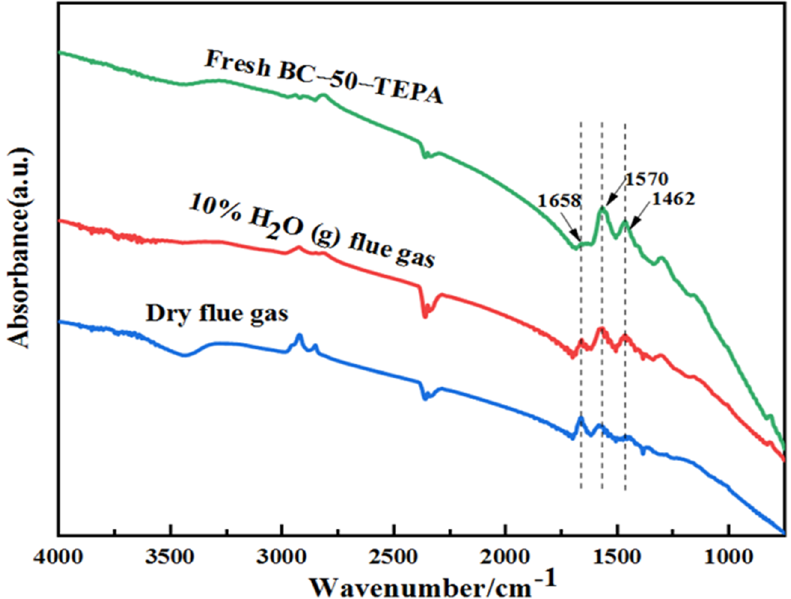
Figure 10. FTIR spectra of the CBC-50-TEPA after 10 cycles in different SFGs.